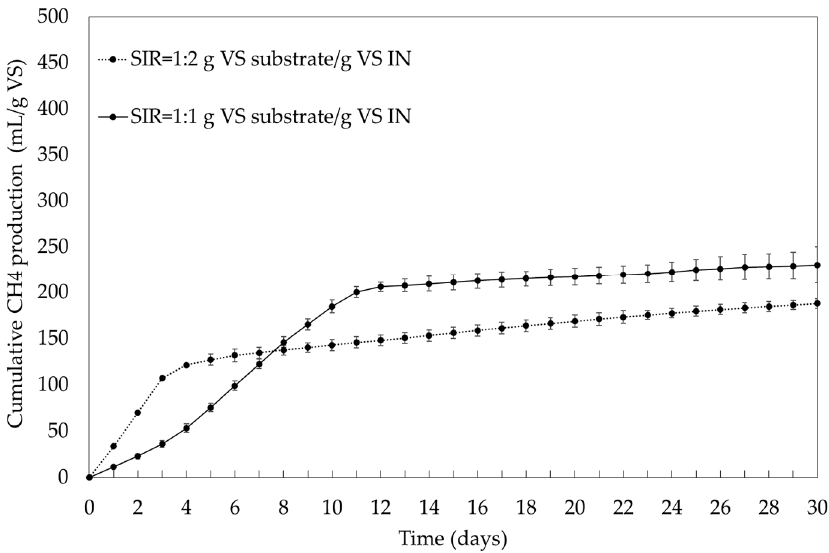
Figure 3. Cumulative methane production of primary sludge (PS) at different substrate to inoculum ratios (error bars indicate standard deviation of mean values).